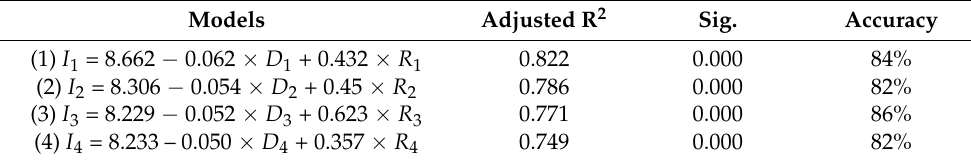
Table 6. Results of regression analysis with different mobile phone signaling types.